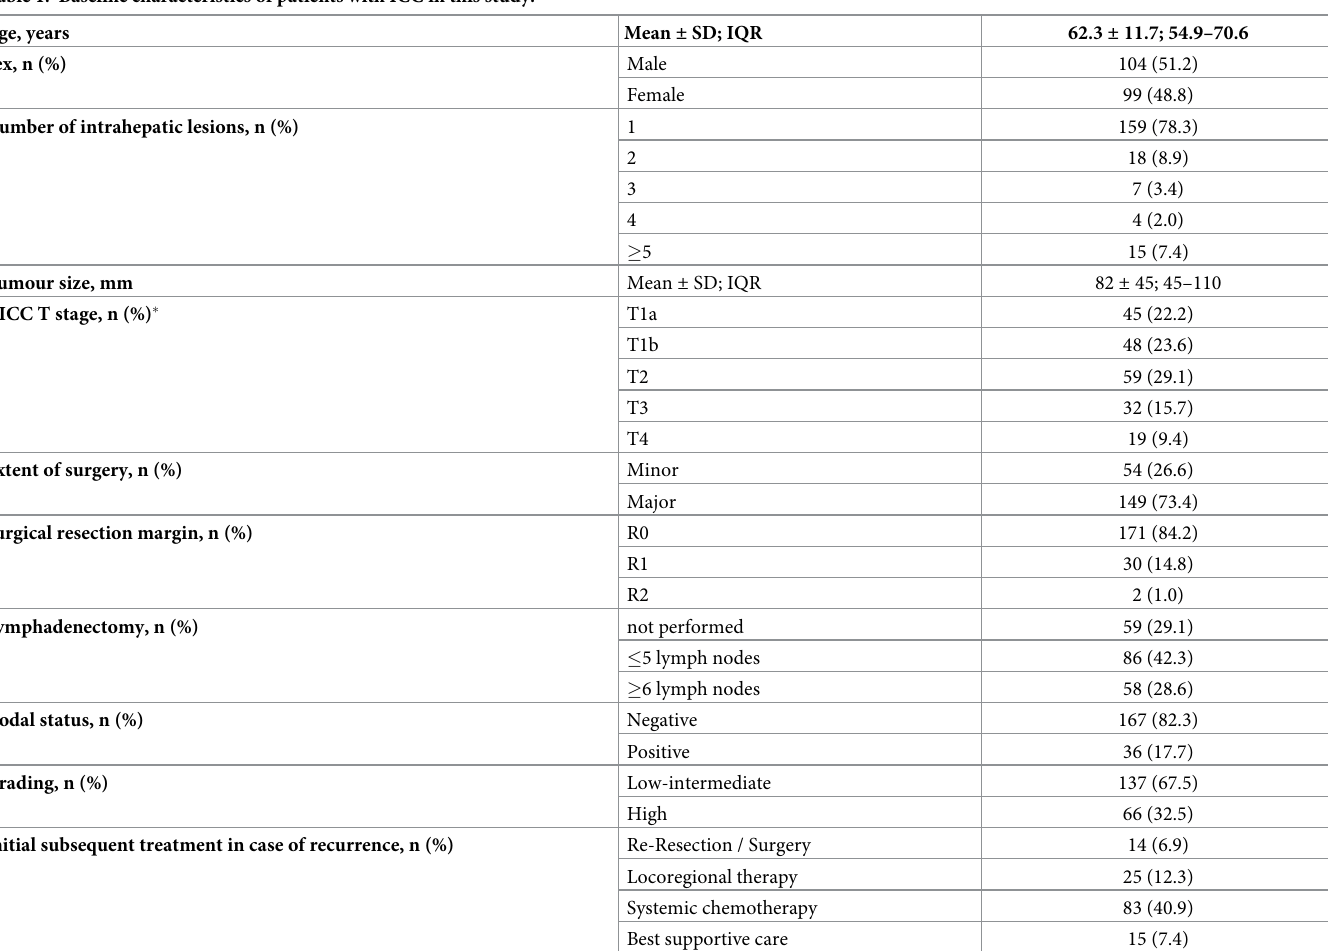
Table 1. Baseline characteristics of patients with ICC in this study.